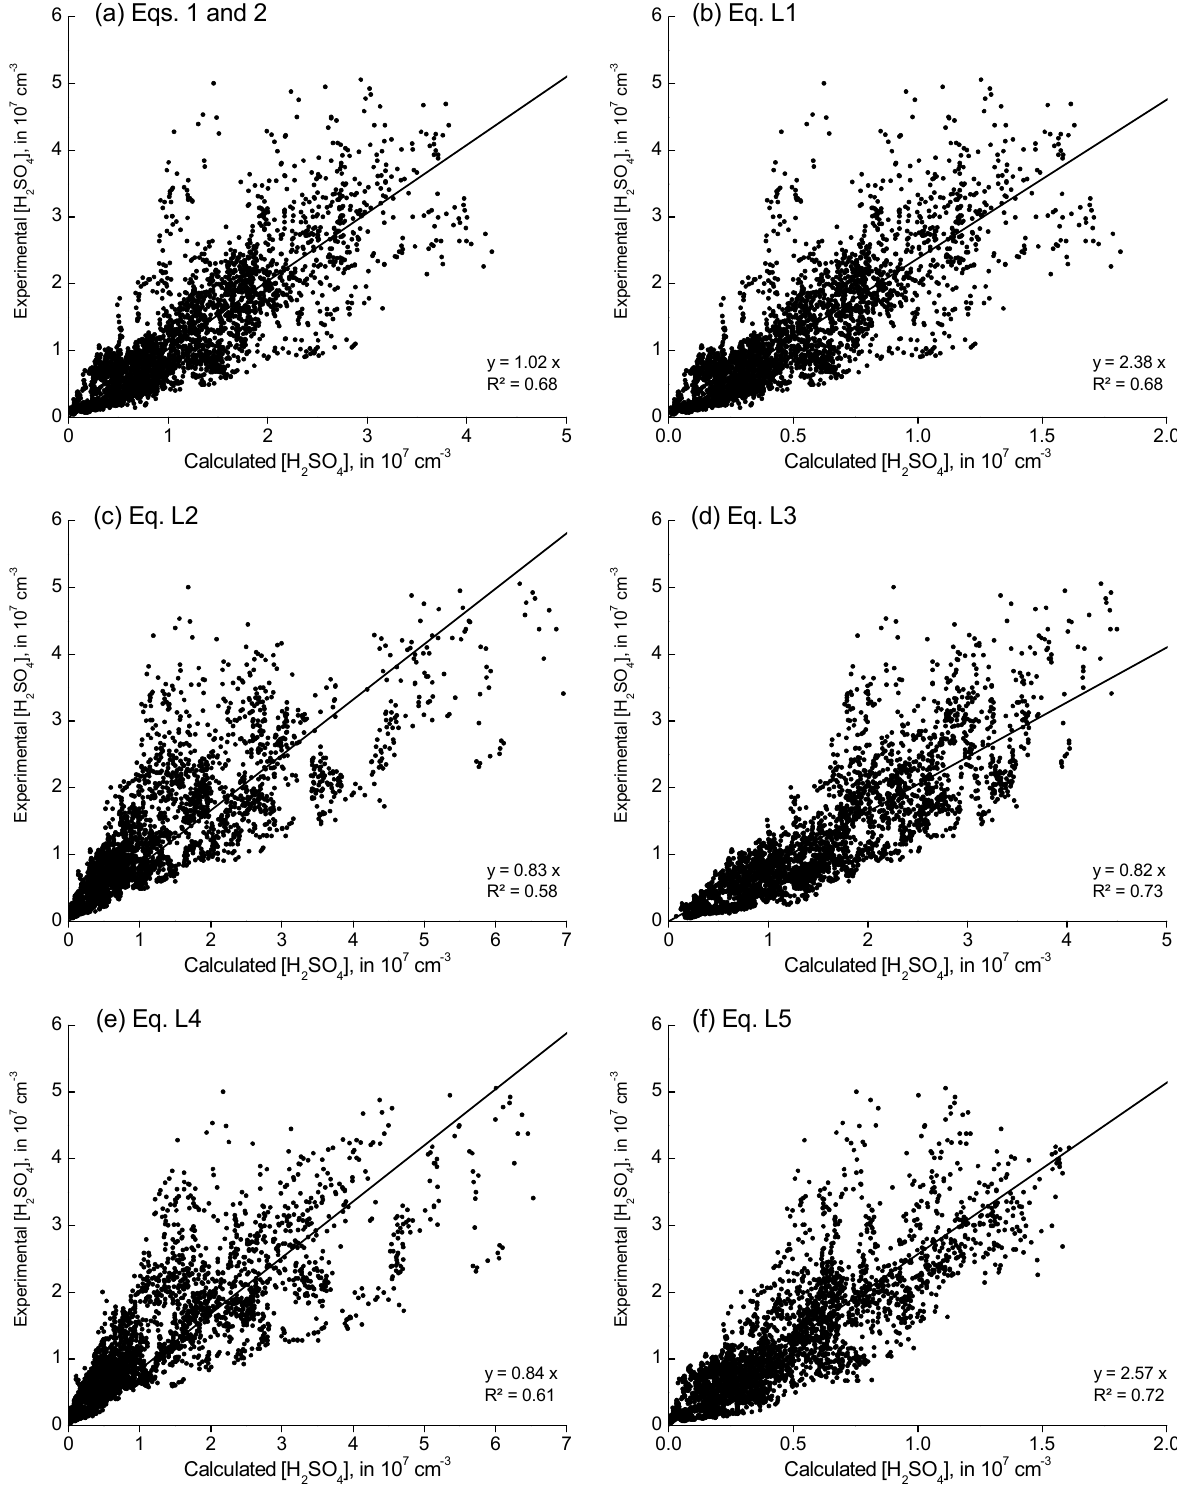
Figure B1. Extended version of Fig. 2 illustrating alternative expressions for the H 2 SO 4 proxy listed in Table B1 (Mikkonen et al., 2011): (a) this work, Eqs. (1) and 2, (b) L1, (c) L2, (d) L3, (e) L4, (f) L5. The data clouds refer to 9 days of measurements during the EUCAARI campaign in